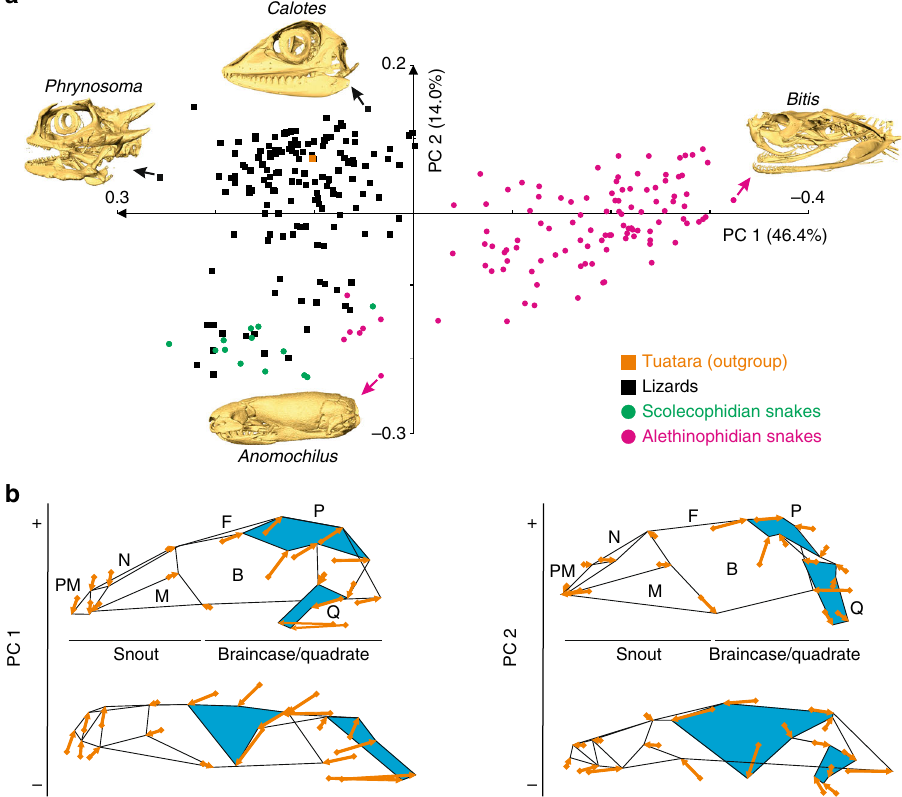
Fig. 2 Principal component analysis of skull shape variation in extant adult squamate species. a Plot of principal component (PC) scores showing the skull shape distribution of lizards (black squares), scolecophidians (green circles), alethinophidians (red circles), and tuatara (outgroup, orange square) for which 2D data were available. Numbers in brackets indicate the percentage of variance explained by each of the PC axes. The 3D-rendered skulls (with species names) corresponding to the observed extreme species in both positive and negative directions are shown. b For each PC, the extreme shapes at positive (+) and negative ( − ) values are depicted as skull outlines with vectors of landmark displacement (orange arrows) indicating the direction and intensity (re fl ected by vector length) of shape changes from the mean shape. Different regions of the skull are visible by black lines connecting landmark points: B, back of the skull; F, frontal; M, maxilla; N, nasal; P, parietal; PM, pre-maxilla; Q, quadrate. Parietal and quadrate bones, showing the greatest variations in size and shape, are shaded in blue